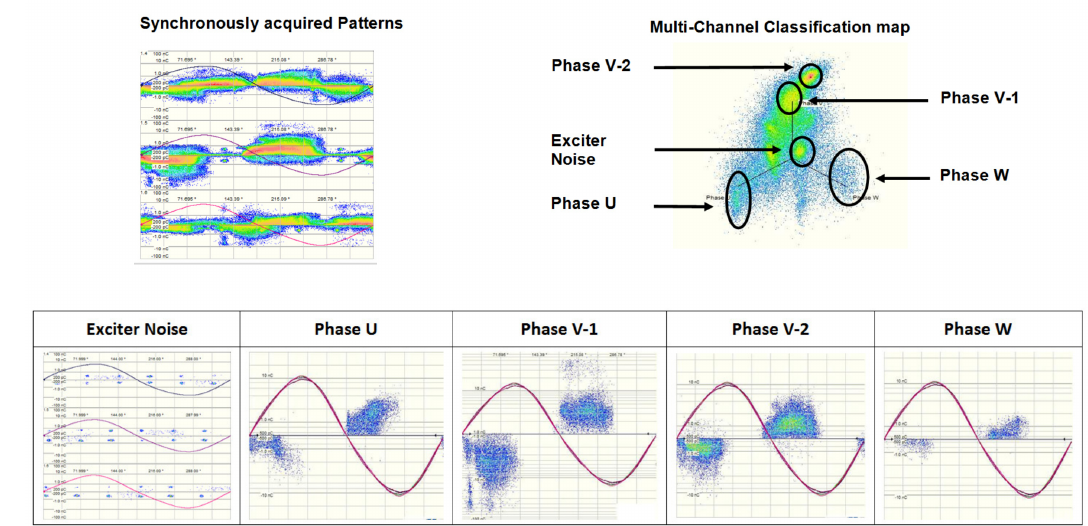
Figure 15. Patterns